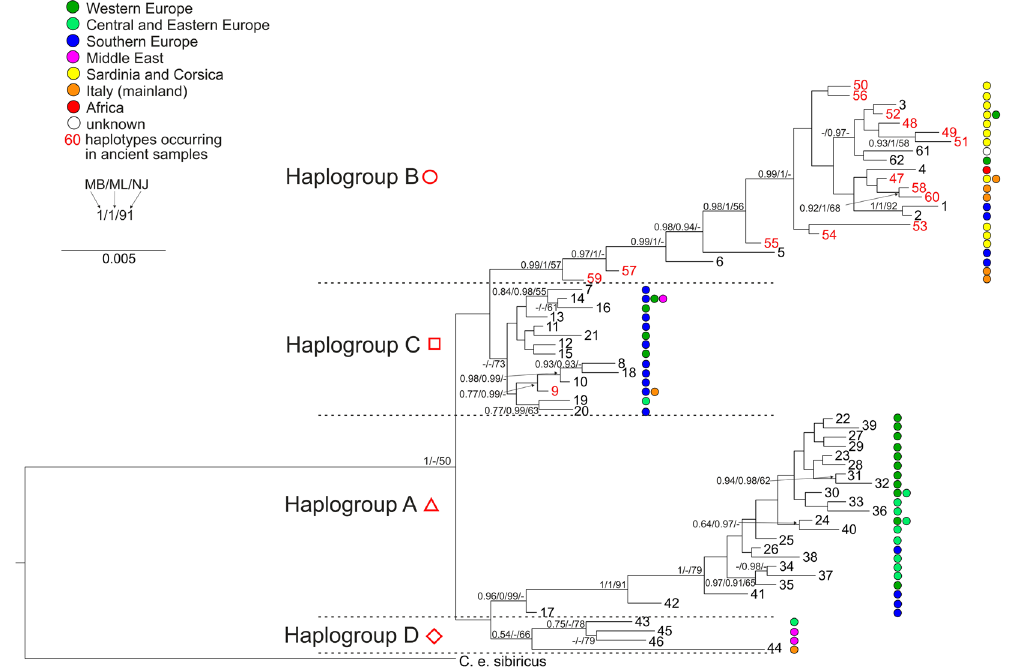
Figure 2. Phylogenetic tree of red deer cytb haplotypes obtained in MrBayes. Coloured circles next to haplotype numbers represent their geographic distribution. Haplotypes occurring in ancient samples are given in red numbers. Numbers at nodes correspond to: Bayesian posterior probability estimated in MrBayes (MB), aBayes support estimated in PhyML (ML) and bootstrap values obtained in PAUP for the neighbor-joining tree (NJ). Node support values lower than 0.5 or 50% are indicated by dashes or not shown.